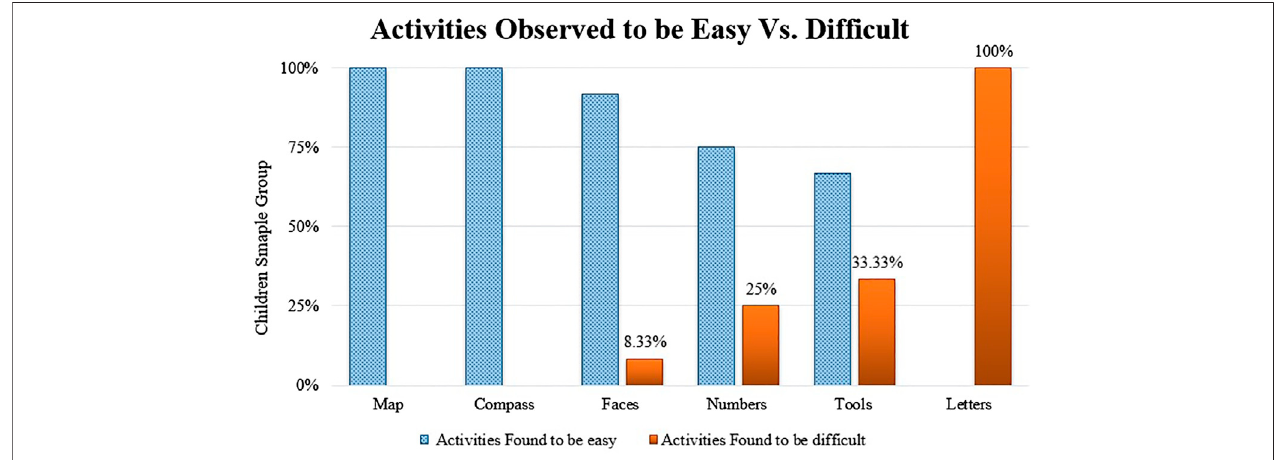
FIGURE 6 | Activities found to be easy or dif fi cult according to the results of the unstructured observation.